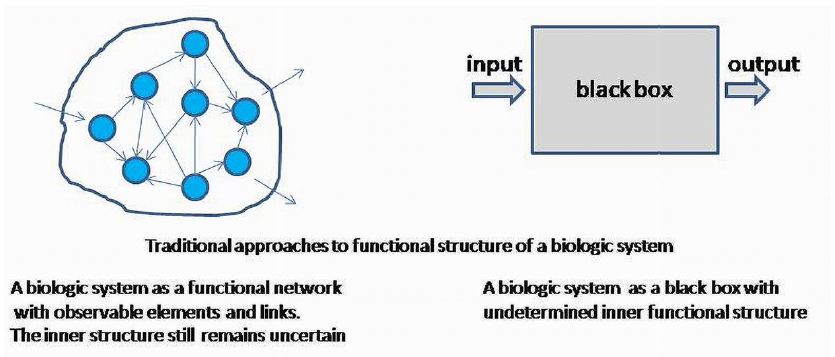
Figure 2. A biologic system: internal functional structure. A biologic system (module) is genetically reproducible morphological and functional unit maintaining its wholeness during the life